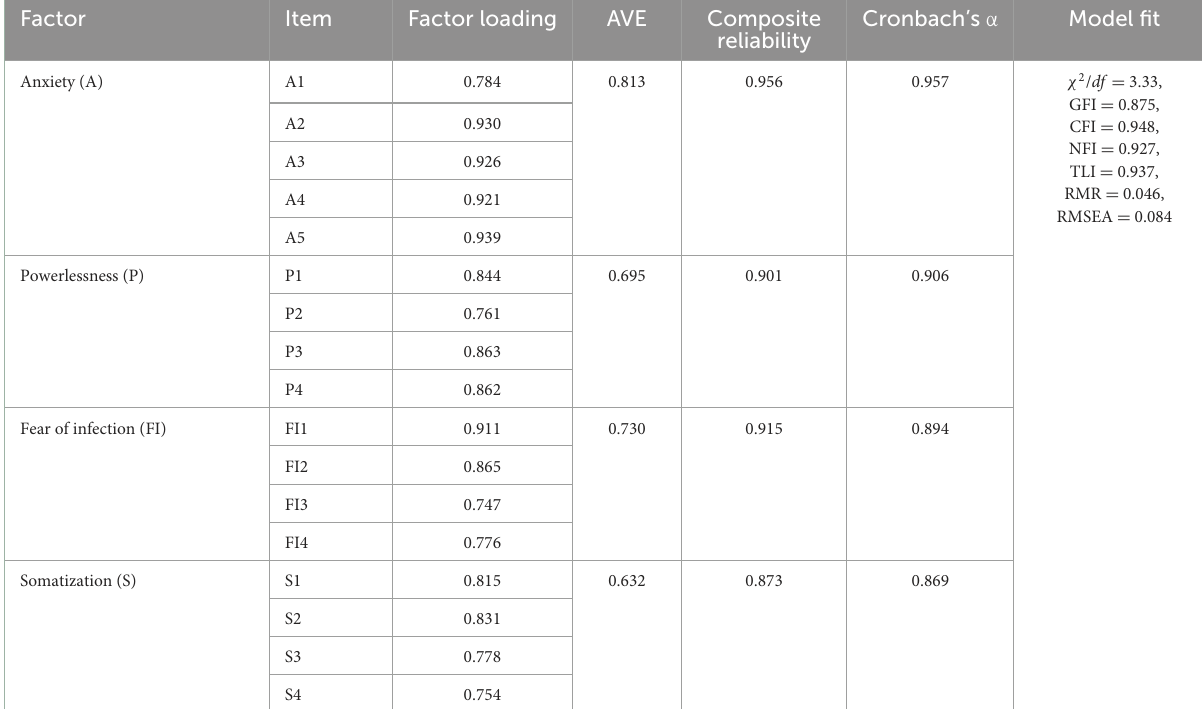
TABLE 3 Results of reliability and validity